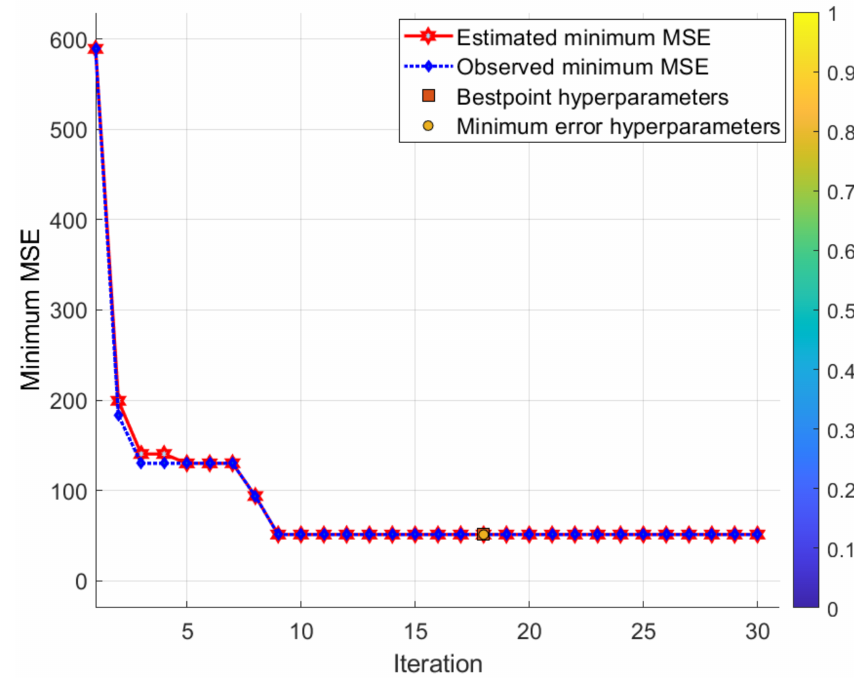
Figure 6. Model training progress.